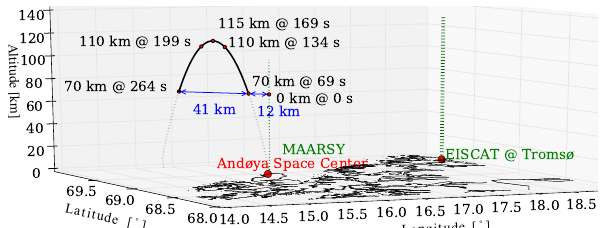
Figure 7. Geometry of in situ and ground-based measurements dur- ing WADIS-1 sounding rocket